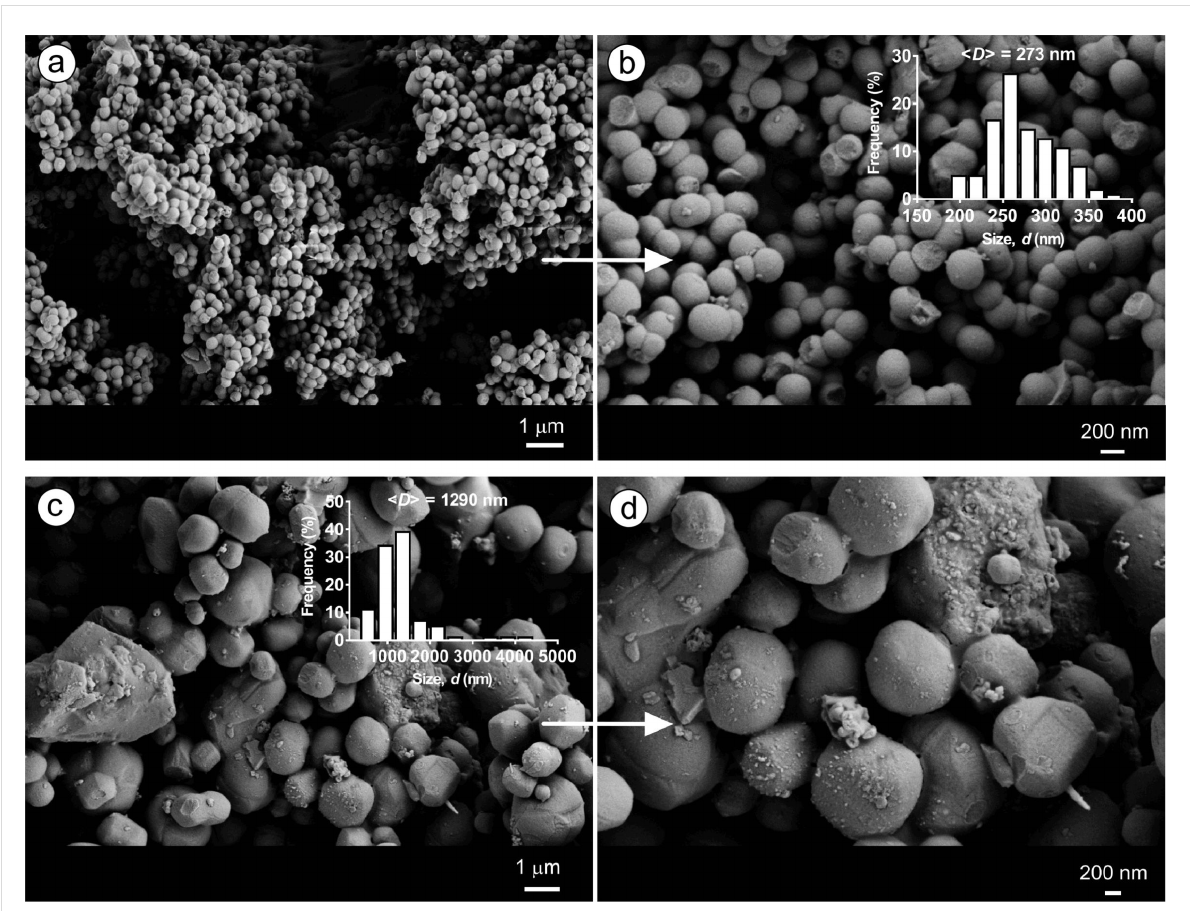
Figure 4: SEM images of MSNs produced using β -CD (MSN-4 (a, b)) and HP- β -CD (MSN-5 (c, d)). (a, b) c β -CD = 0.25 (w/v) and r (CD/CTAC) = 2.5, and (c, d) c HP- β –CD = 0.25% (w/v) and r (CD/CTAC) = 2.5. Insets show the size-distribution plots of the respective particles.